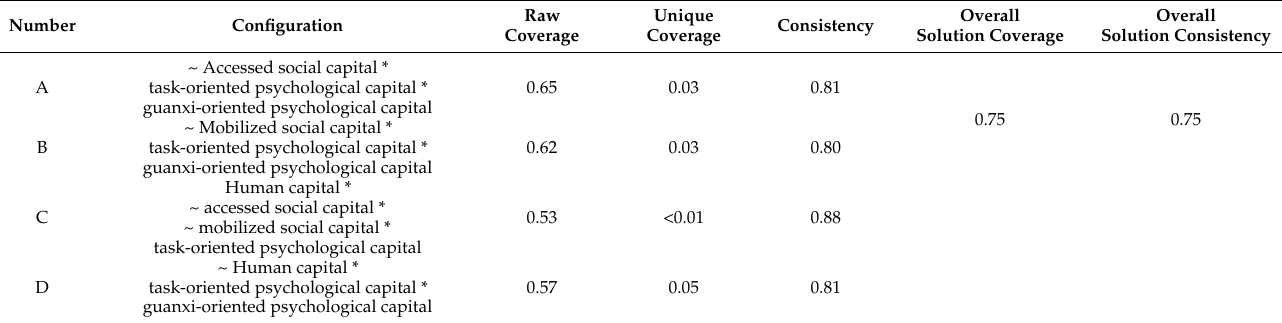
Table 2. Configurations for achieving high subjective well-being.